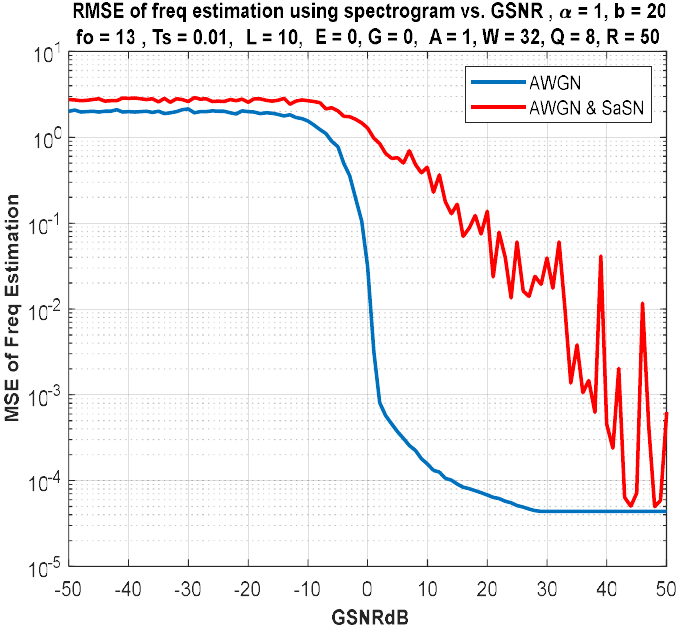
Figure 25. MSE versus GSNR for TFD of noisy single tone signal by spectrogram, where α = 1 and b = 20.